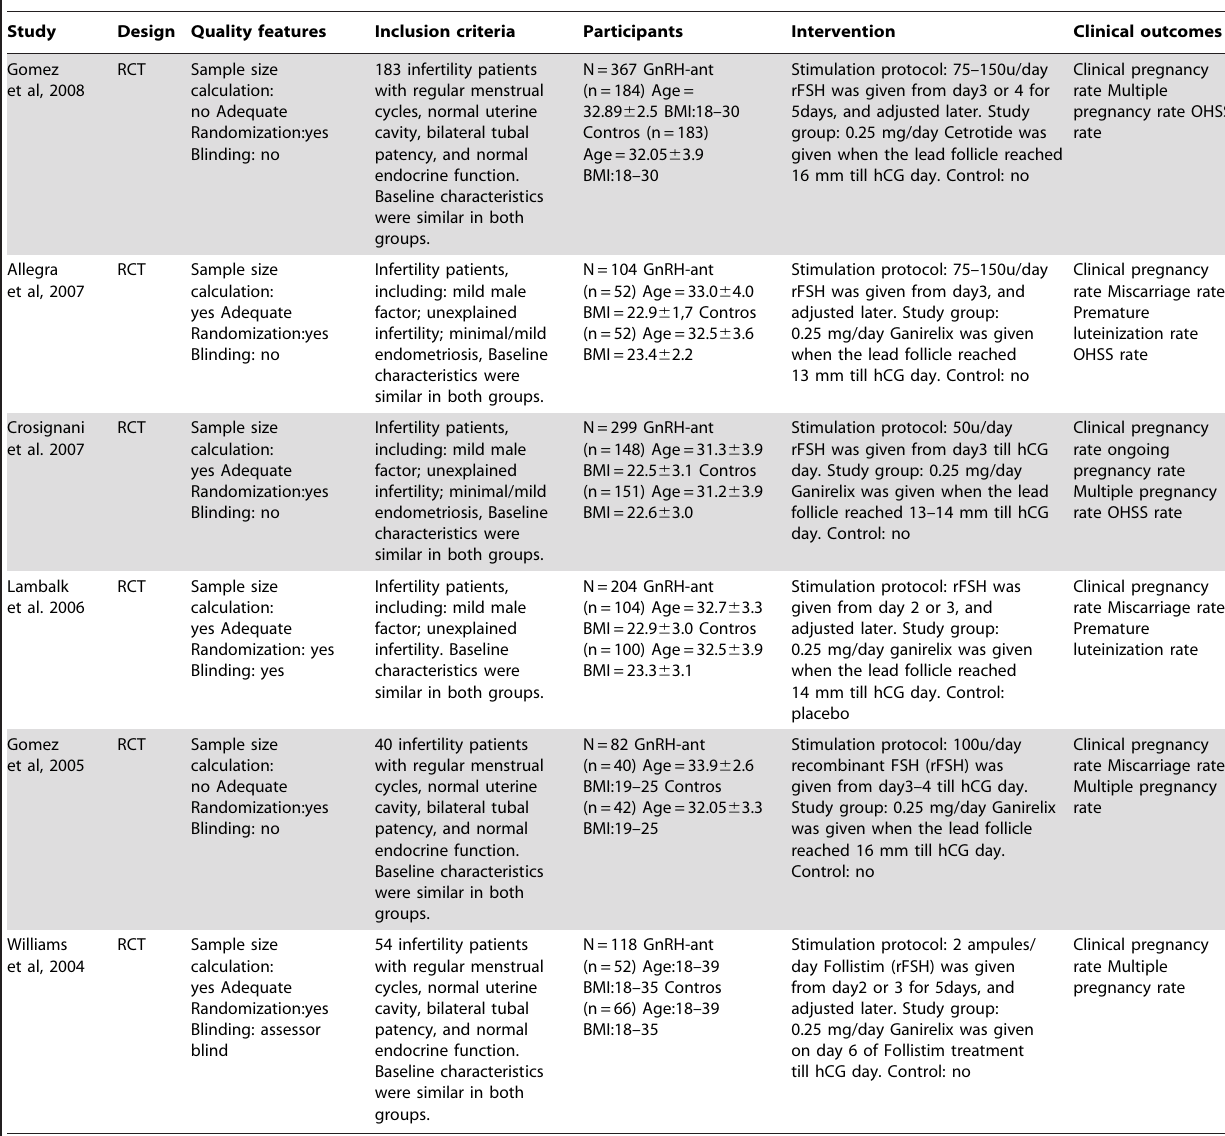
Table 2. Summary of study characteristics and clinical outcomes.